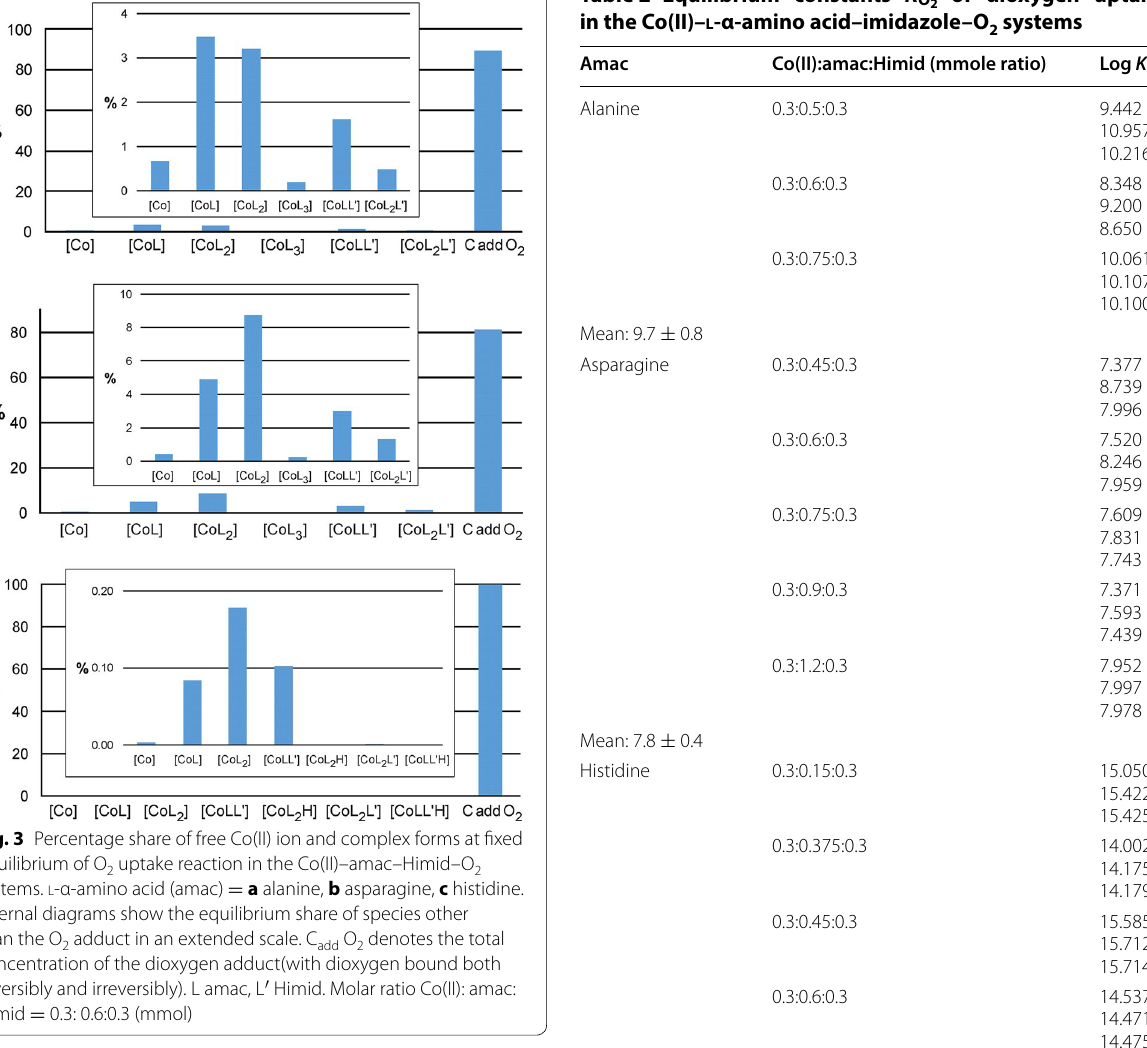
Table 2 Equilibrium constants K O 2 of dioxygen